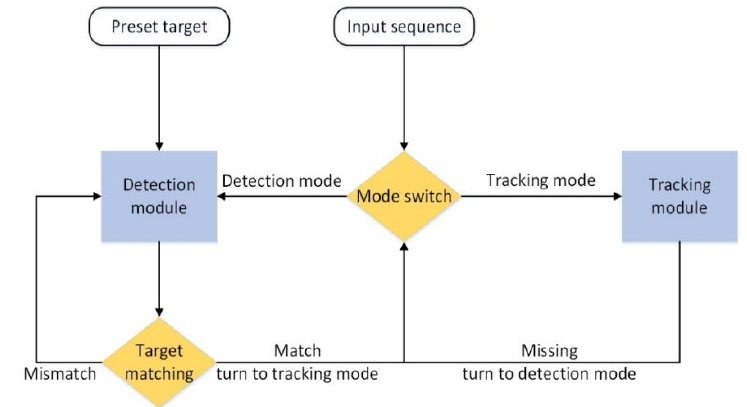
Figure 1. Target detection-tracking framework.